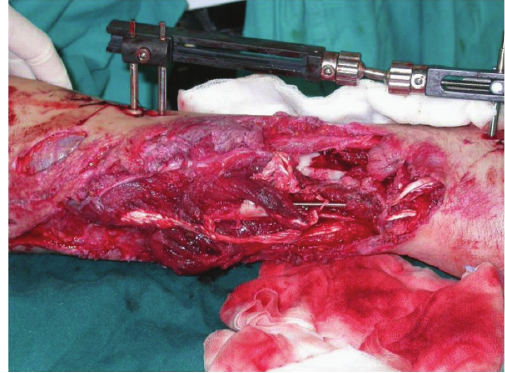
Figure 4: Postoperative at 2